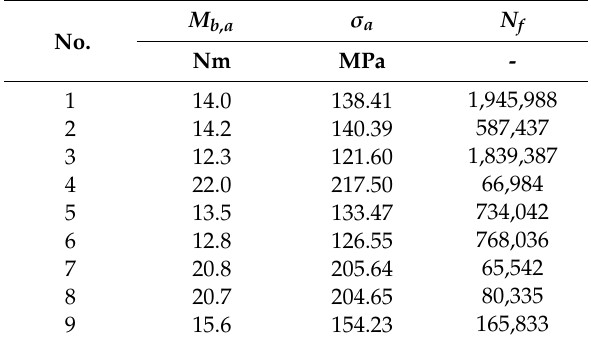
Table 8. Results of fatigue tests of samples after 7 days in a 3.5% NaCl solution in demineralised water. No.